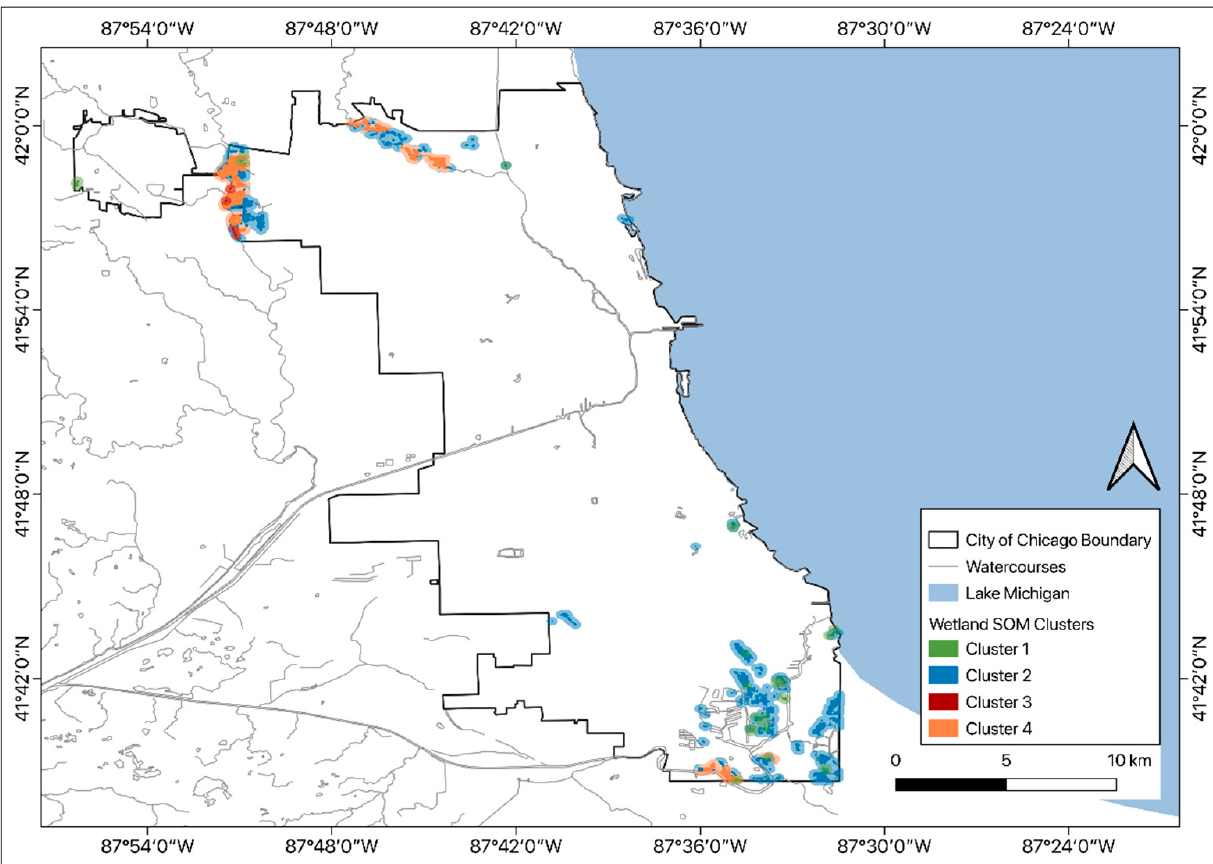
Figure 13. Chicago wetland SOM clusters.